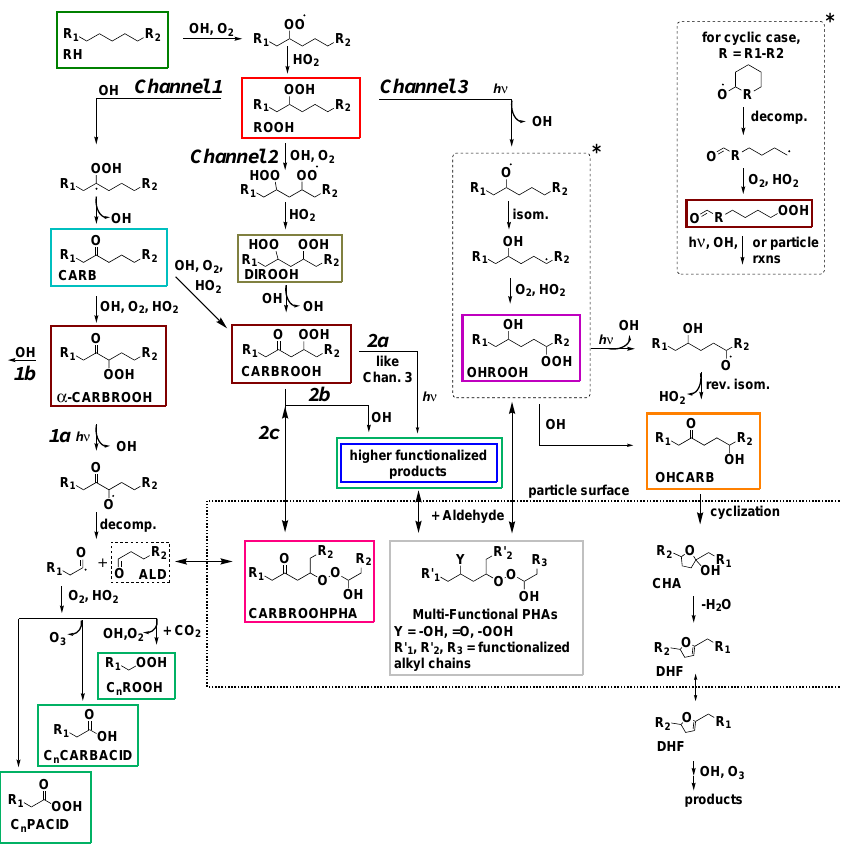
Fig. 1. General mechanism for alkanes under low-NO x conditions. R 1 and R 2 are alkyl groups. Solid boxed compounds indicate proposed structures monitored by the CIMS in the gas-phase and/or the AMS in the particle-phase. Pathway in upper right with asterisk denotes alternative pathway for the cyclic case (R 1 and R 2 are bonded together as